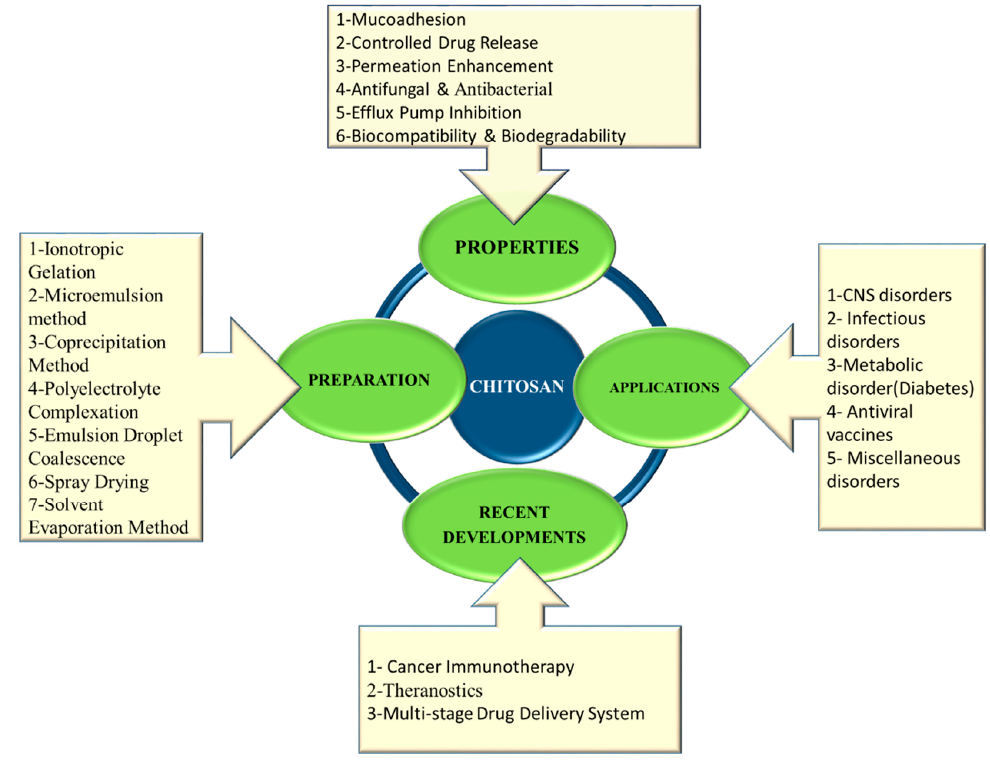
Figure 3. Multifaceted chitosan in drug delivery.